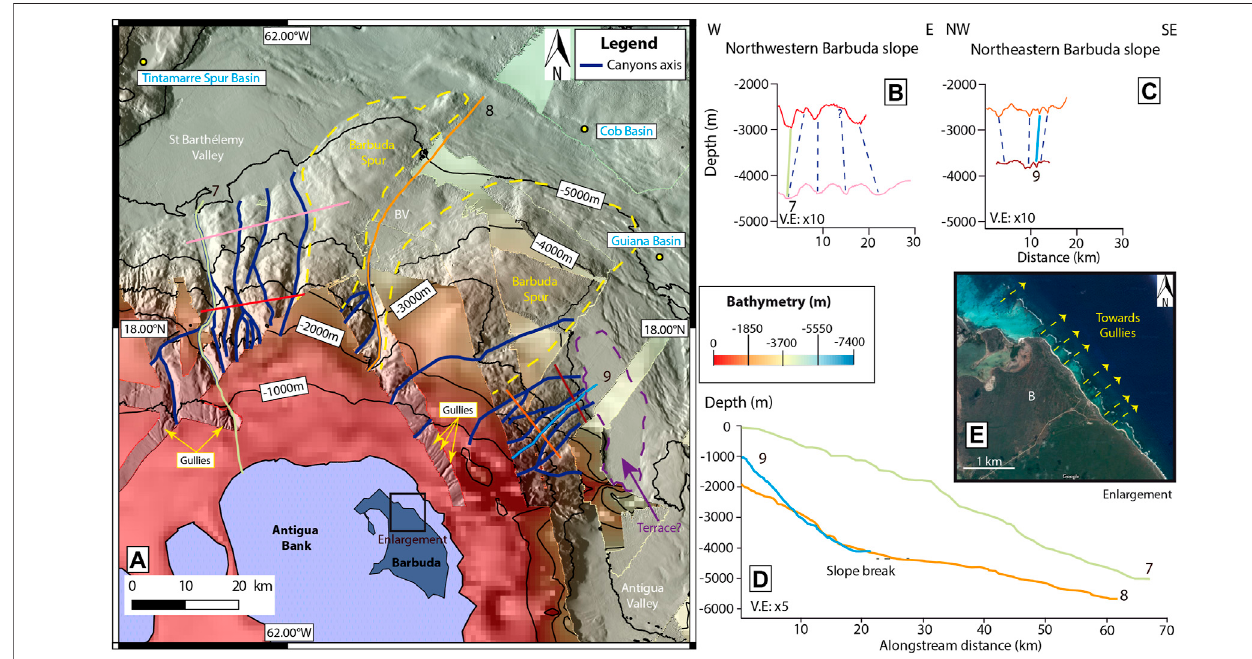
FIGURE 9 | (A) Enlargement of the northern slope of the Antigua Bank. BB: Barbuda Basin, BV: Barbuda Valley. Three canyons axis (7, 8, and 9) are represented and referred in Figures9B – D . (B) W-E cross-sectionsofthenorthwesternslopeoftheAntigua Bank.Thered cross-section isbetween2,500and 3,000 mbsl, thelight pink cross-section is between 4,300 and 4,600 mbsl. (C) W-E cross-sections of the northeastern slope of the Antigua Bank. The orange cross-section is between 2,400 and 2,900 mbsl and the brown cross-section is between 3,700 and 3,900 mbsl. Blue dots follow canyons axis between the two cross-sections. (D) Bathymetric pro fi les of three canyons axis (7, 8, and 9). (E) Enlargement of Barbuda Island ’ s passes. The Enlargement comes from Google